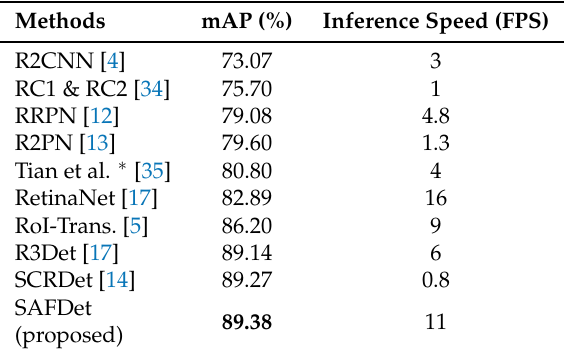
Table 4. Results comparison with the state-of-the-art methods on HSRC2016